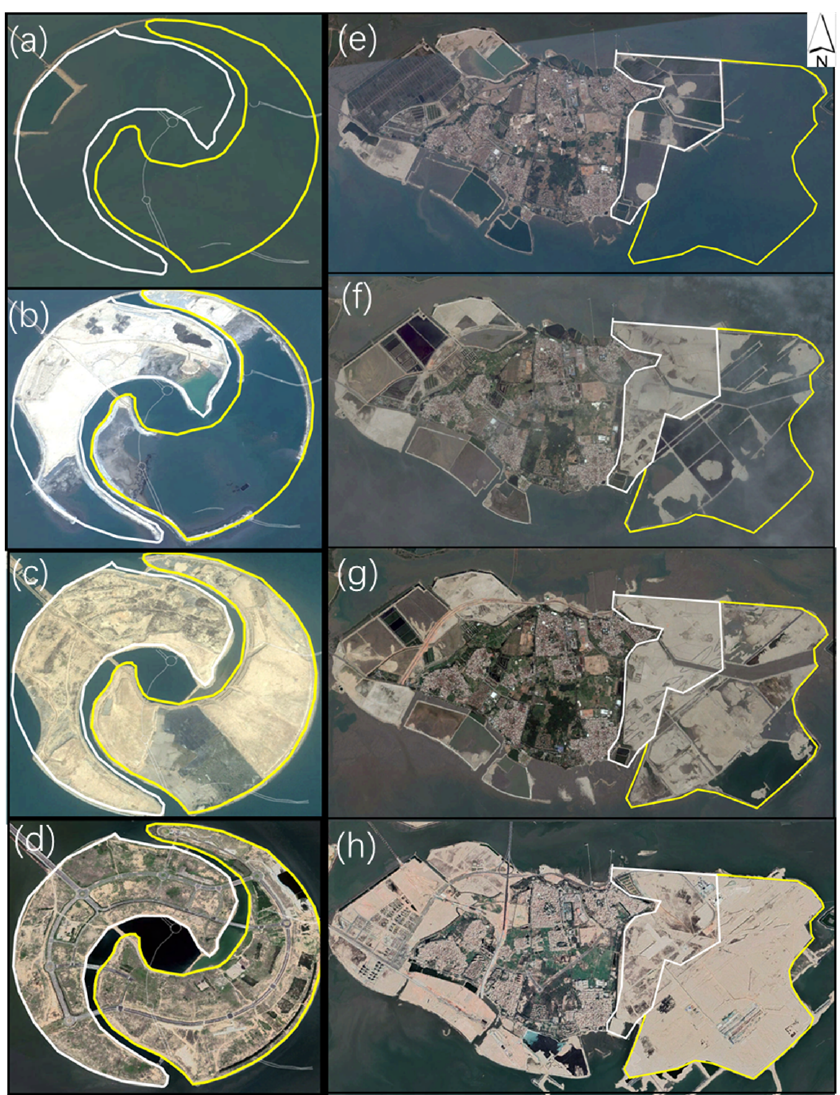
Figure 12. Four remote sensing images of Shuangyu Island were acquired on ( a ) 20 December 2010, ( b ) 1 January 2012, ( c ) 12 January 2014, and ( d ) 27 July 2021. Four remote sensing images of Dadeng Island were acquired on ( e ) 27 July 2014, ( f ) 16 June 2015, ( g ) 24 June 2016, and ( h ) 14 January 2021. The white lines indicate the first stage of land reclamation, and the yellow lines indicate the second stage.